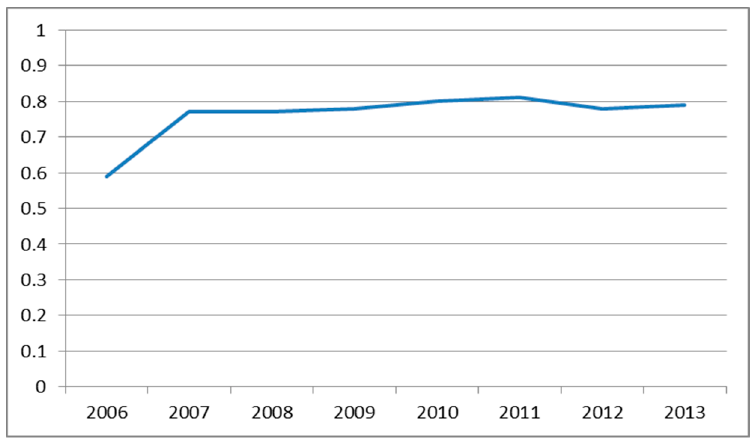
Figure 4. Average efficiency of banks in CEE countries in the time period 2006–2013 using output net loans. Source: processing using data from